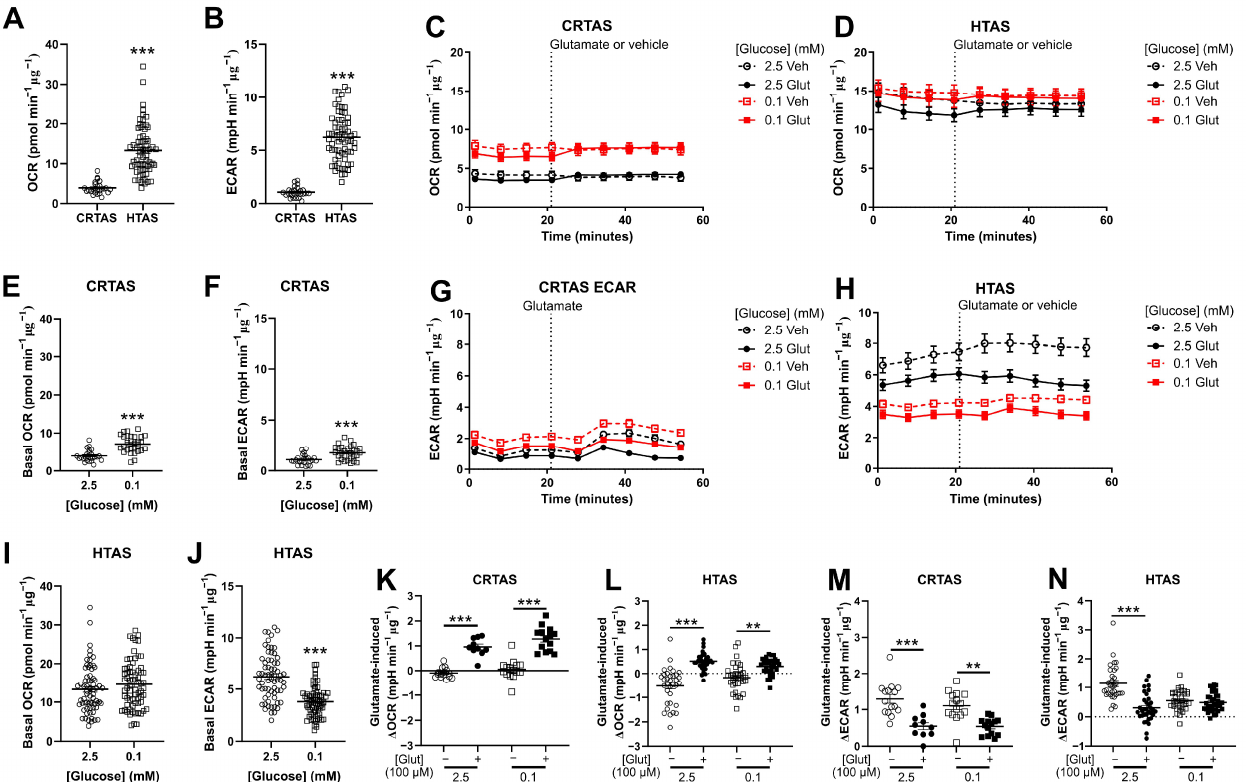
Figure 4. Low glucose does not affect glutamate-induced metabolic changes in primary rat astrocytes. Oxygen consumption rate (OCR) and extracellular acidification rate (ECAR) were measured from CRTAS and HTAS in 2.5 mmol/L glucose before any treatments. HTAS have a significantly higher OCR ( A ) and ECAR ( B ) than CRTAS. Astrocytes were simultaneously treated to 1 h of 0.1 mmol/L glucose and measurements of OCR and ECAR taken before they were treated with vehicle or glutamate (100 µ mol/L) ( C , D , G , H ). Basal OCR of CRTAS ( E ). Basal ECAR of CRTAS ( F ). Basal OCR of HTAS ( I ). Basal ECAR of HTAS ( J ). Peak ∆ OCR after vehicle or glutamate treatment of CRTAS ( K ) and HTAS ( L ). Peak ∆ ECAR after vehicle or glutamate treatment of CRTAS ( M ) and HTAS ( N ). Error bars represent standard error of the mean. Two-tailed unpaired t test. One-way ANOVA with post hoc Tukey’s multiple comparison tests. ** p < 0.01; *** p < 0.001. CRTAS 2.5 mmol/L glucose with vehicle (n = 15); CRTAS 2.5 mmol/L glucose with glutamate (n = 10); CRTAS 0.1 mmol/L glucose with vehicle (n = 15); CRTAS 0.1 mmol/L glucose with glutamate (n = 14); HTAS 2.5 mmol/L glucose with vehicle (n = 34); HTAS 2.5 mmol/L glucose with glutamate (n = 34); HTAS 0.1 mmol/L glucose with vehicle (n = 35); HTAS 0.1 mmol/L glucose with glutamate (n = 33). Open circles and closed circles represent 2.5 mmol/L glucose with vehicle-treated cells respectively. Open squares and closed squares represent 0.1 mmol/L glucose with glutamate-treated cells